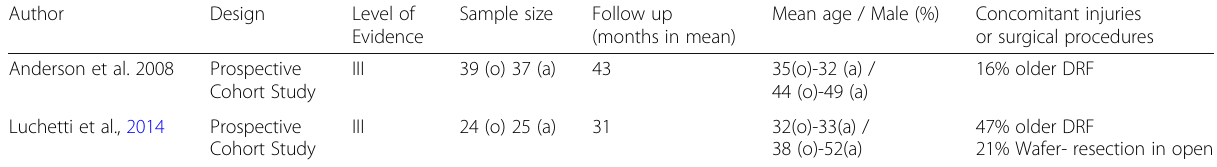
Table 1 Study characteristics (DRF = distal radius fracture, o = open TFCC repair, a = arthroscopic TFCC repair)